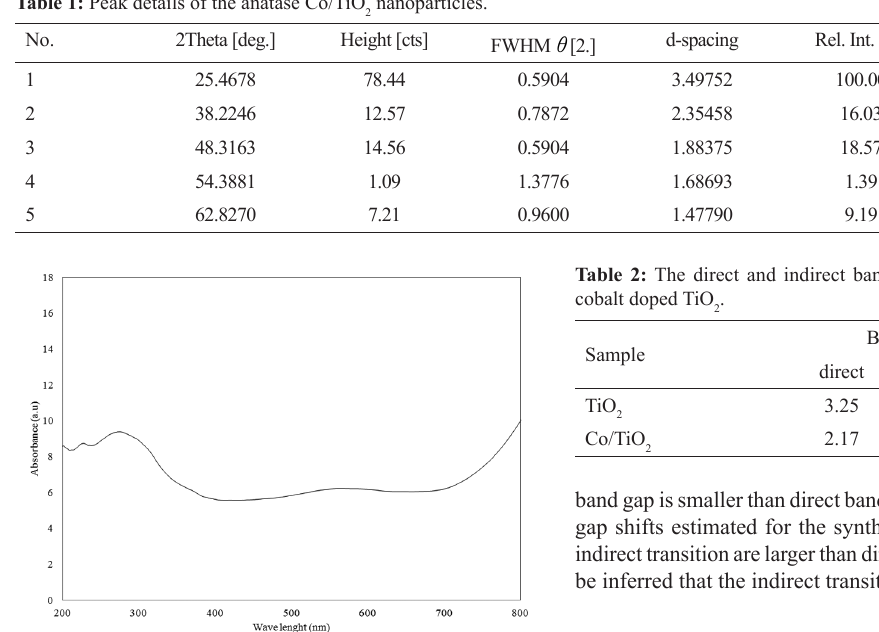
Table 1: Peak details of the anatase Co/TiO